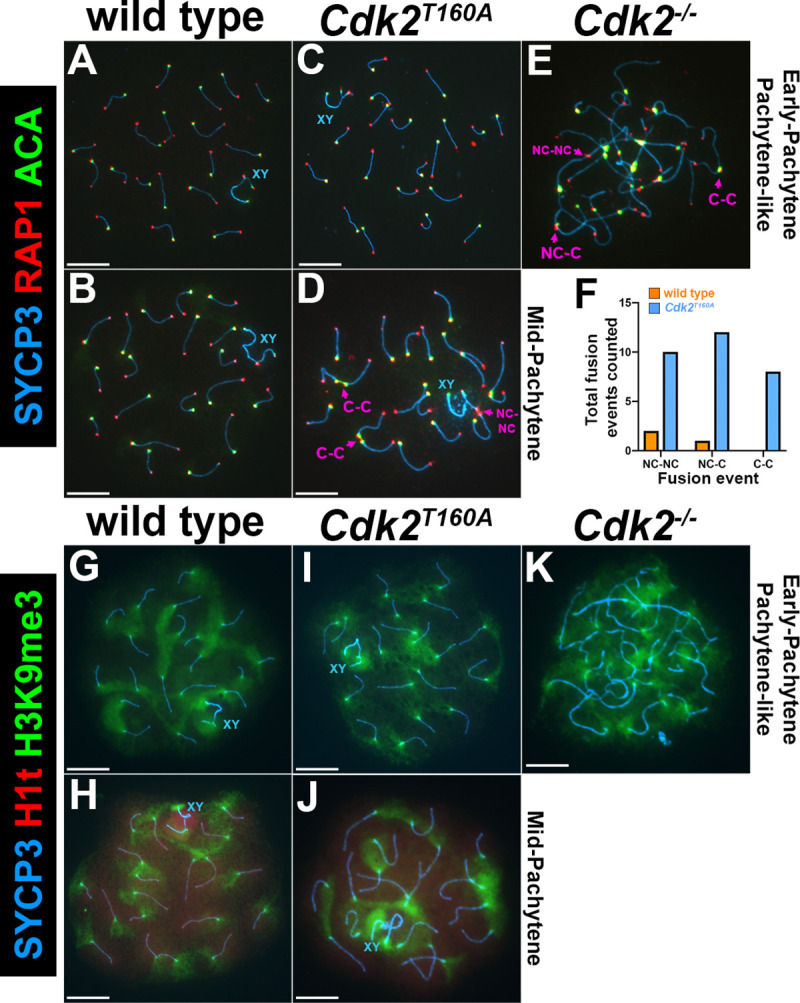
Analysis of telomeric fusion defects in Cdk2T160A spermatocytes.Chromosome spread preparations from adult (postnatal day 40) testes immunostained with ACA (green) and the telomeric shelterin protein RAP1 (red) in conjunction with SYCP3 (blue) are shown for WT (A–B), Cdk2T160A (C–D), and Cdk2−/− (E) for selected stages of meiotic prophase I. For each of the 3 genotypes, RAP1 and ACA can be detected at the telomeres and centromeres as specific foci, respectively. The centromeric ACA signal is always detected proximal to a telomeric RAP1 signal because of the proximity of the centrosome to telomeric ends in mouse chromosomes. In pachytene-like Cdk2−/− spermatocytes (E) and mid-pachytene–stage Cdk2T160A spermatocytes (D), telomere fusions can be observed. Quantification of fusion events (F) specifically for mid-pachytene–stage nuclei was performed for WT (orange bars, N = 3 total events counted) and Cdk2T160A spermatocytes (blue bars, N = 30 total events counted). Here, data are presented as the total number of NC–NC, NC–C, and C–C fusions, respectively. For each genotype, fusion events were counted from 90 images pooled from 3 biological replicates in which at least 20 images were taken from each replicate; no statistical test is applied because of the low numbers of countable events. Examples of C–C, NC–C, and NC–NC fusions are shown in panels D–E by pink arrows. Additional staining is shown for the pericentromeric chromatin marker, H3K9me3 (green) in conjunction with SYCP3 (blue) for WT (G–H), Cdk2T160A (I–J), and Cdk2−/− (K), for selected stages of meiotic prophase I. Histone H1t (red) positivity also shown and is indicative of mid-pachytene stage onwards. In all WT and Cdk2T160A images, pericentric chromatin can be visualized as a flare-like staining emanating from the end of bivalents. In Cdk2−/−, aggregates of H3K9me3-positive pericentromeric chromatin show the extensive interactions between centromeric ends. All images within Fig 2 are representative of at least 20 images taken for specified stages. Similar staining patterns were confirmed in at least 3 biological replicates. In all main panels, scale bars are representative of 5 μm; in all inset pictures, scale bars are representative of 1.25 μm. The underlying data for (F) can be found in S1 Data. ACA, autocentromere antibody; CDK2, cyclin-dependent kinase 2; C–C, centromeric end to centromeric end; H3K9me3, trimethylated lysine 9 of histone H3; NC–C, noncentromeric end to centromeric end; NC–NC, noncentromeric end to noncentromeric end; RAP1, TERF2 interacting protein; SYCP, synaptonemal complex protein; WT, wild-type.